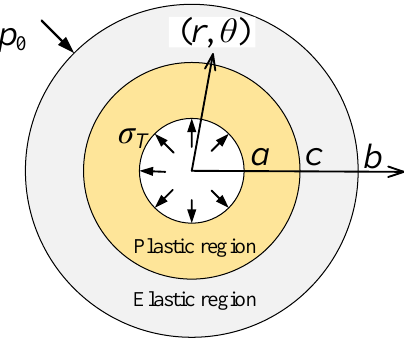
Figure 2. Distribution of the elastic and plastic zone.